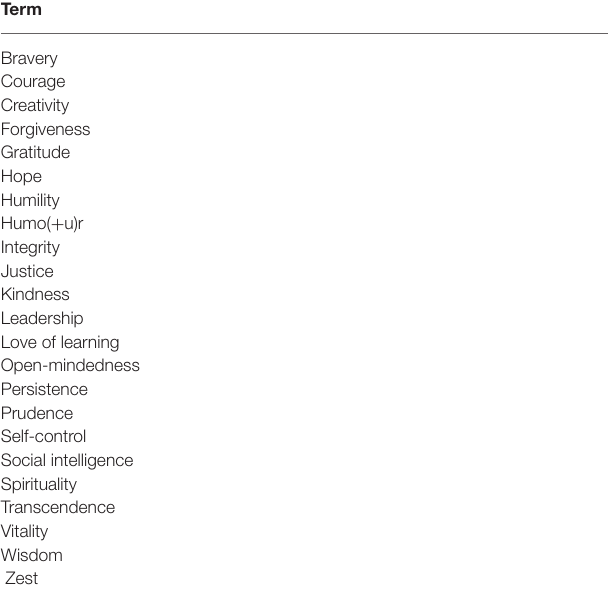
TABLE 1 | Positive character